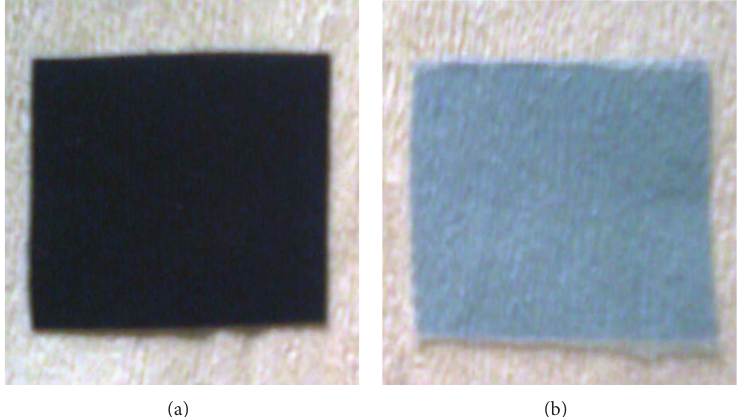
Figure 7: Decomposition of gelatin layer of X-ray film by protease. (a) Control; (b) experimental: X-ray film after 3 h exposure to protease.